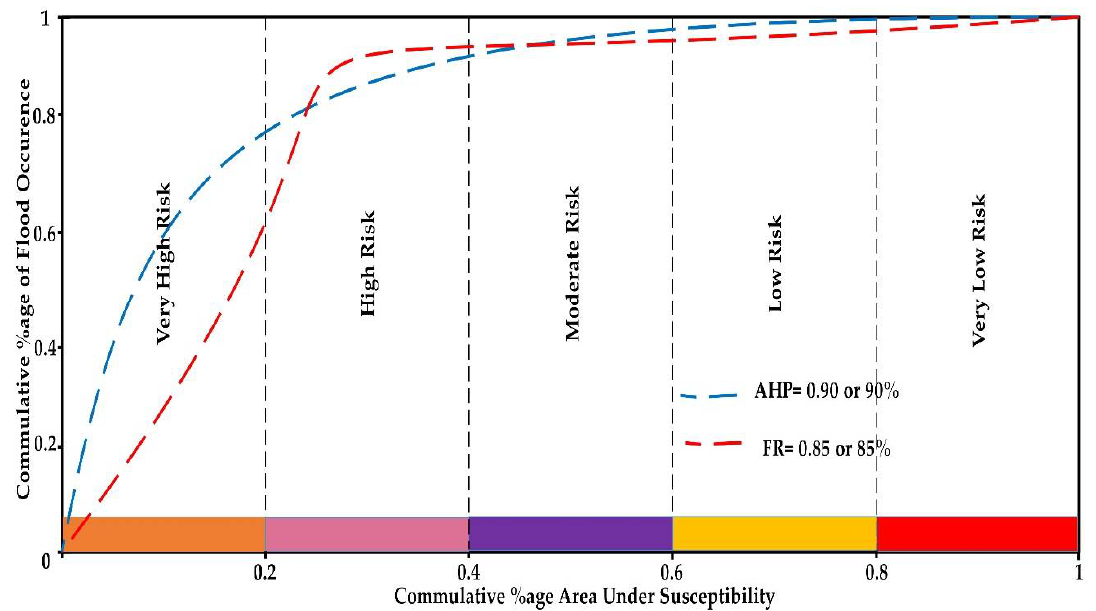
Figure 7. Area Under the Curve (AUC) related to susceptibility model validation of AHP and FR.